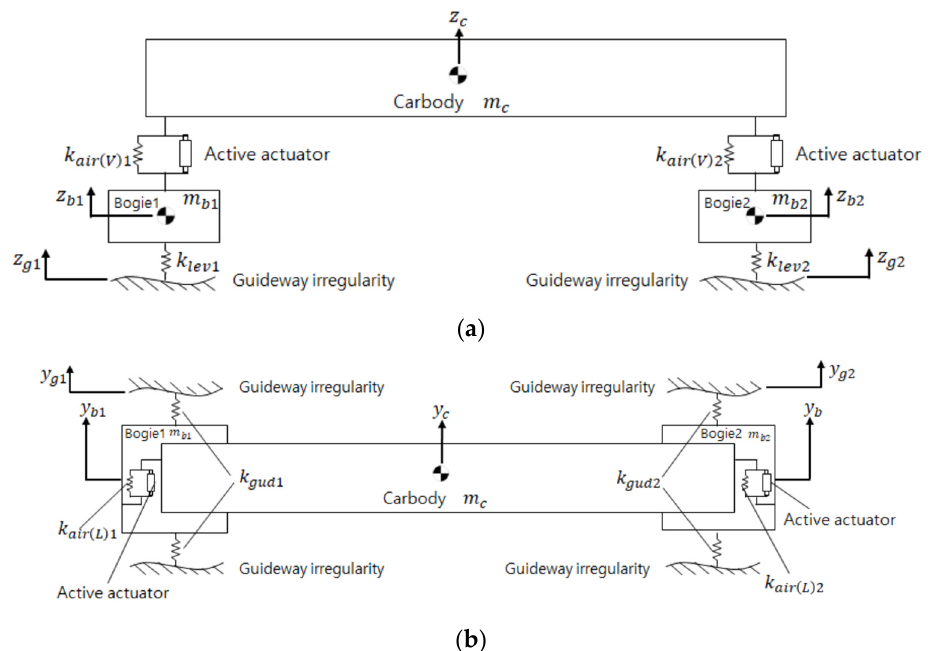
Figure 2. Spring-mass model corresponding to the vehicle: ( a ) vertical model on x-z plane, ( b ) lateral model on x-y plane.